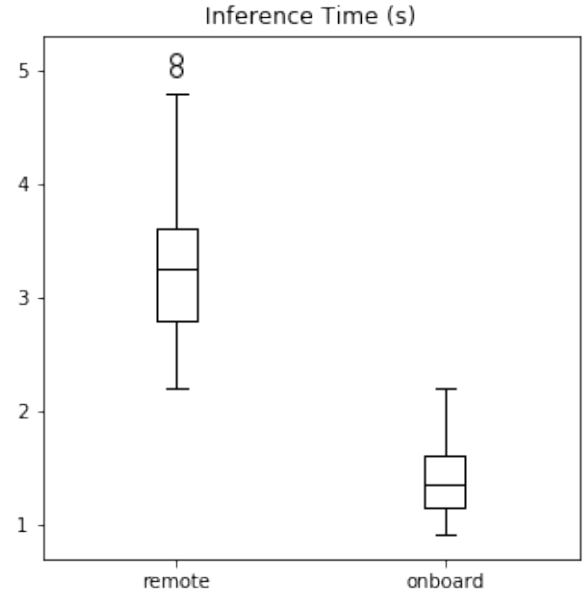
Figure 9. Inference